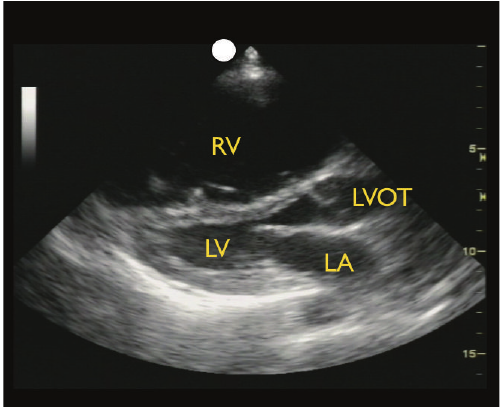
Figure 11: Right ventricular dilation, parasternal long axis view. RV: right ventricle, LA: left atrium, LV: left ventricle, LVOT: left ventricle outflow tract.